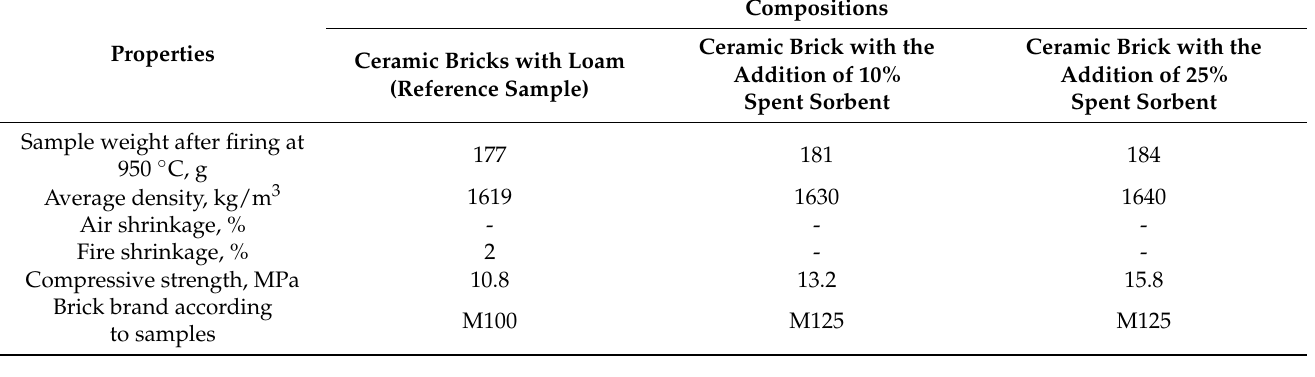
Table 8. Physical and mechanical properties of fired samples.